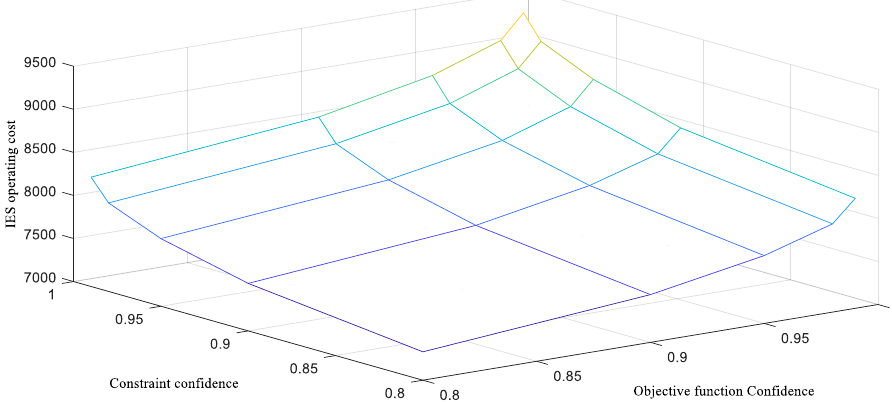
Figure 10. The relationship between the planned operating cost and the confidence degree of the IES for a typical winter day.